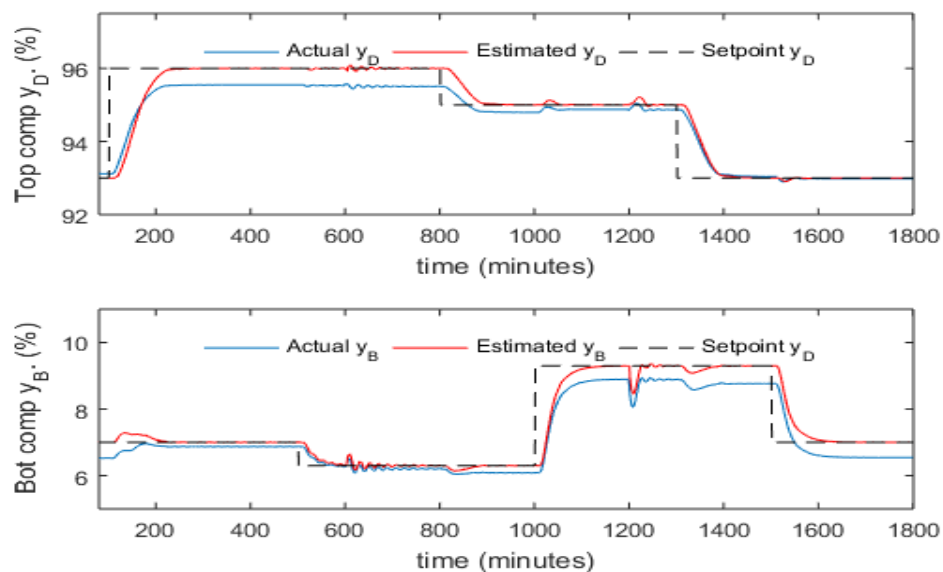
Figure 12. Responses of actual and estimated product compositions under inferential ADRC with 5th order dynamic PCR models (without mean updating).